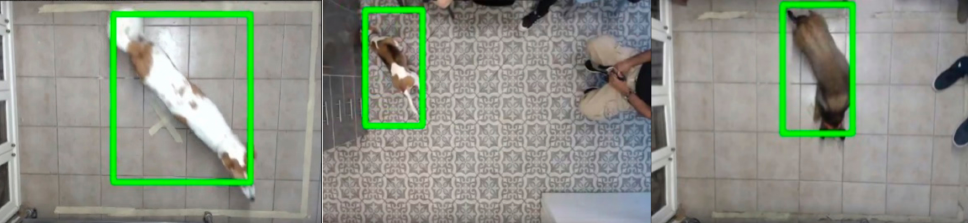
Figure 4. Frames example of dogs being tracked by